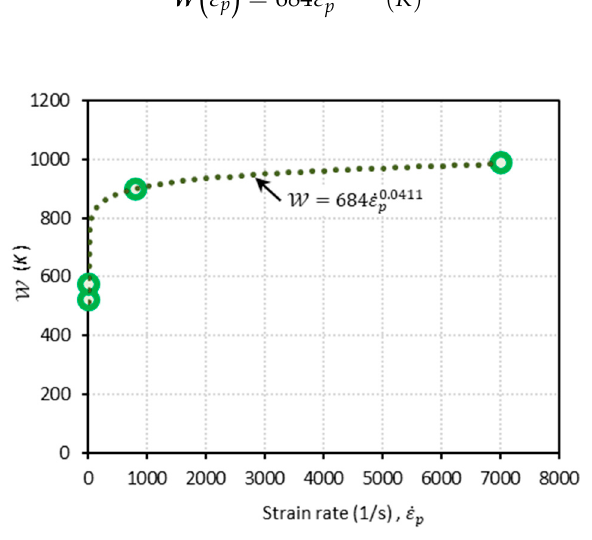
Figure 7. The plot of (cid:2289) versus (cid:2013)(cid:4662) (cid:3043) . Dots for both of the parameters are obtained from the experimental data [1]. The corresponding trend lines are displayed using a power law form.